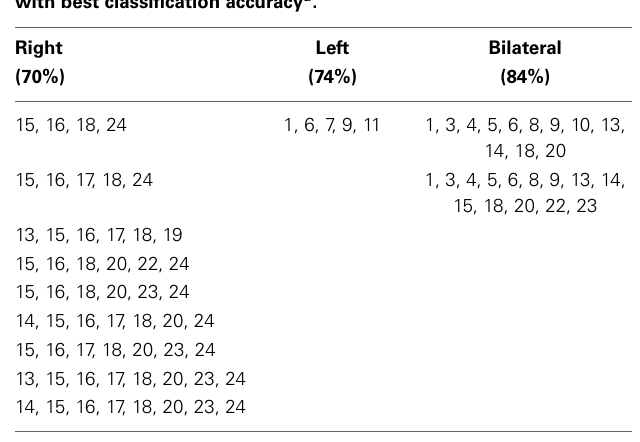
a The numbers indicated the channel numbers. In the right hemisphere, the num- ber of the best subset was nine. The percentage represented in the parenthesis indicating the best classification accuracy for each data set.